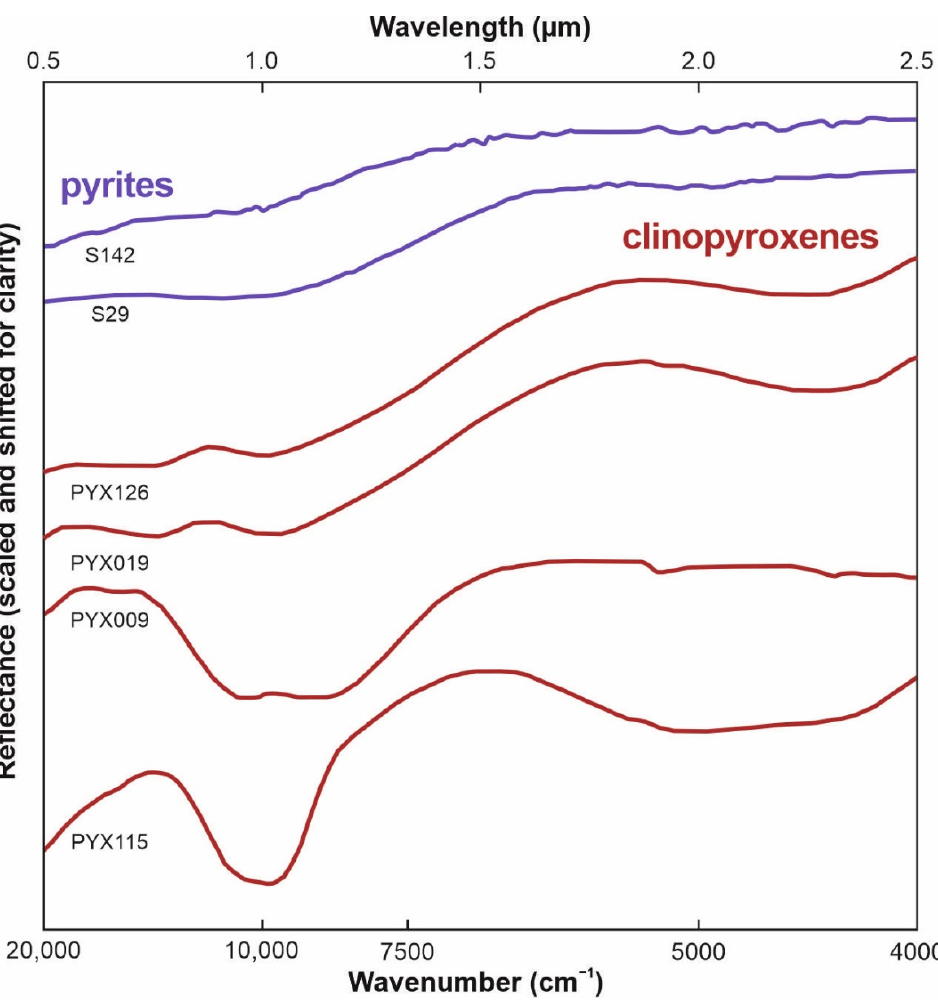
Figure 1. Near-infrared (NIR) spectra of pyrites S142 and S29 compared to those of clinopyroxenes PYX126, PYX019, PYX009 and PYX115, which are all described by Horgan et al. [20]. Note the lack of distinct spectral features in pyrites and their similarity to the NIR spectra of some clinopyroxenes. Considering the low pyrite abundances compared to those of clinopyroxene, pyrite is difficult to observe in the NIR range. The y axis has no numerical scale as the plots are shifted for clarity.